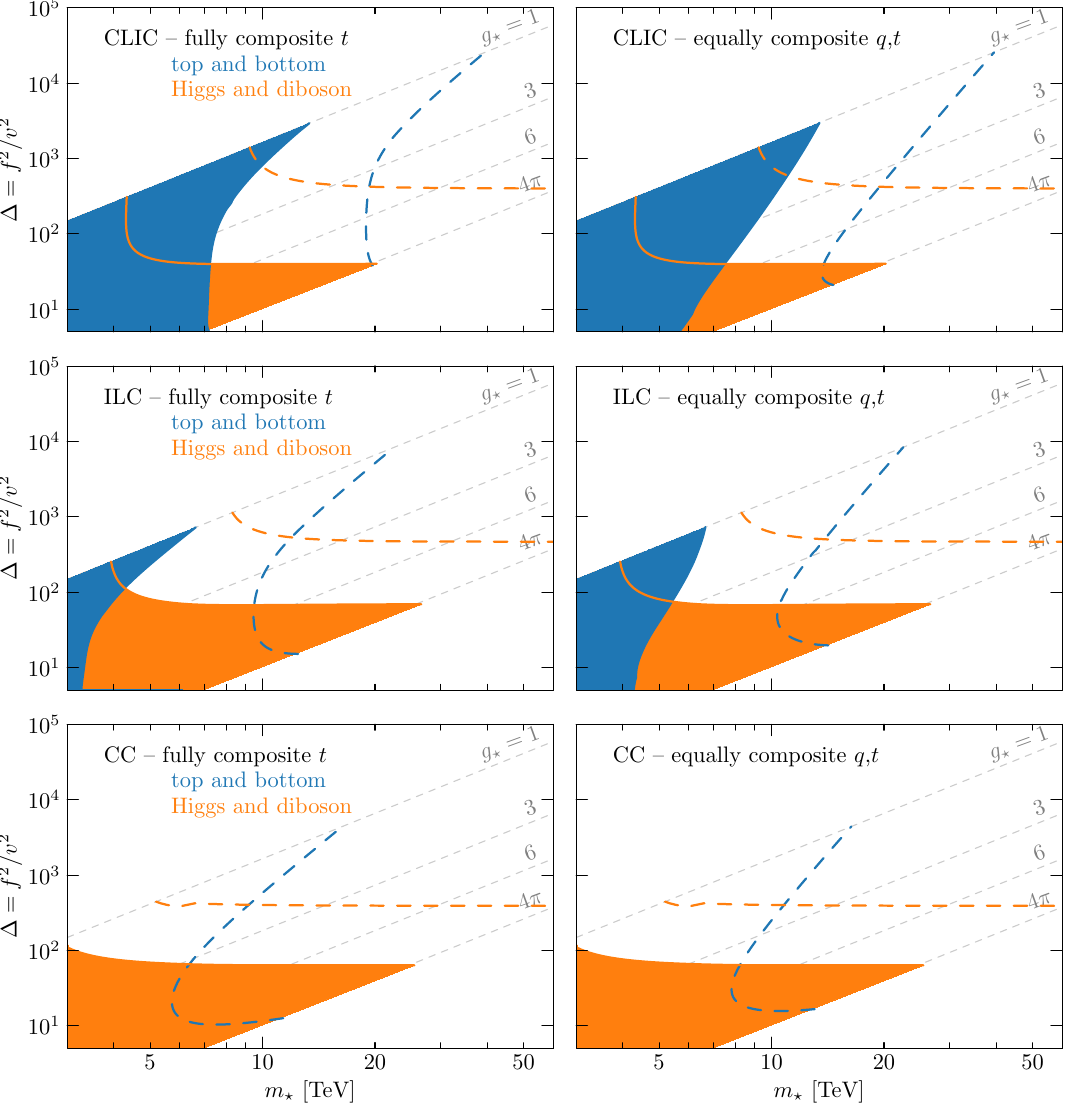
Figure 2 . Five-sigma discovery reach, at future linear and circular lepton colliders, in the CH model parameter space characterized by m ? and (cid:1). The coupling g ? takes constant values on the dashed grey contours. Values below 1 and above 4 (cid:25) are not allowed. The regions probed by top- and bottom-quark pair production measurements are indicated in blue. The orange regions are accessible through the Higgs and diboson measurements. Solid and dashed lines respectively delimit regions probed in pessimistic and optimistic cases. These extremes are obtained by assuming the power-counting estimates of operator coe(cid:14)cients are satis(cid:12)ed up to factors ranging between 1 = 2 and 2, considering all possible combinations of relative signs between